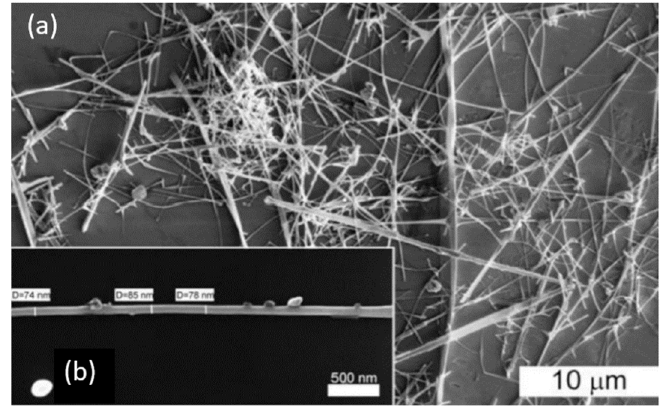
Figure 22 . (a) SEM image of SnO 2 nanowires after the synthesis using the gas transport method based on the vapor-liquid-solid (VLS) mechanism, and (b) SEM image of a single SnO 2 nanowire. Reproduced from Shaposhnik et al. [292]. Published by Beilstein Sci. as open access. The lack of technology for the synthesis of well-controlled one-dimensional structures with an industrial-scale production rate is also a significant limitation [130]. However, the hydrothermal method can be considered as a potential scale-up method for the synthesis of 1D nanomaterials.